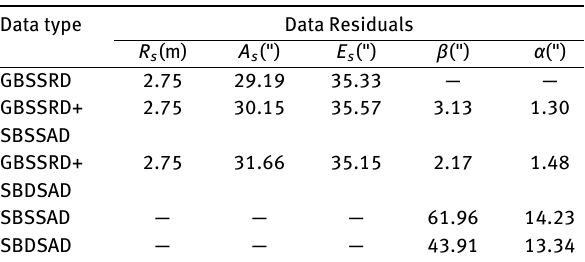
Table 2. The residuals of the short arc data used to determine the